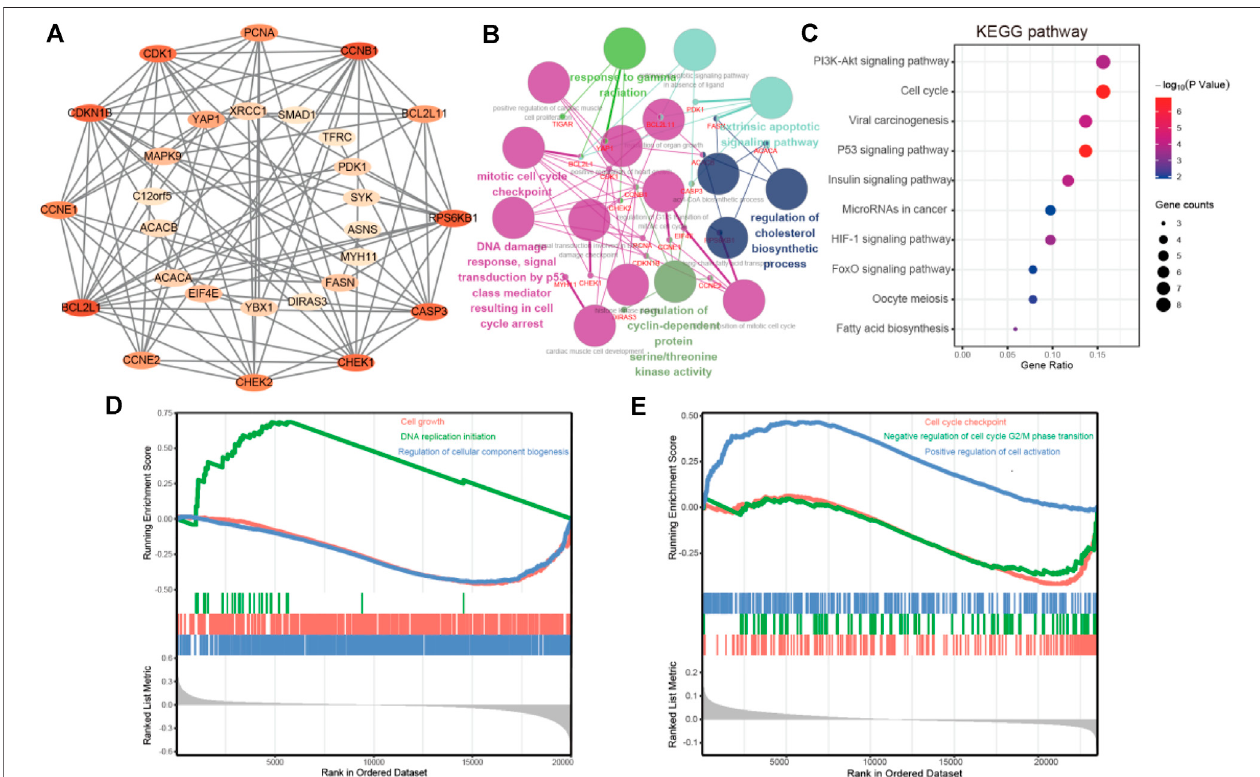
FIGURE5| PPInetworkconstructionandenrichmentanalysisofFATP5correlationgenes. (A) ClusteringanalysisofFATP5co-expressedgenesbySTRINGtools. (B) The biological process analysis of hub genes was performed using the BiNGO plug-in, * p < 0.05. (C) KEGG pathway enrichment analysis of hub genes. GSEA enrichment analysis of FATP5 based TCGA dataset (D) and GSE39582 accession (E) .